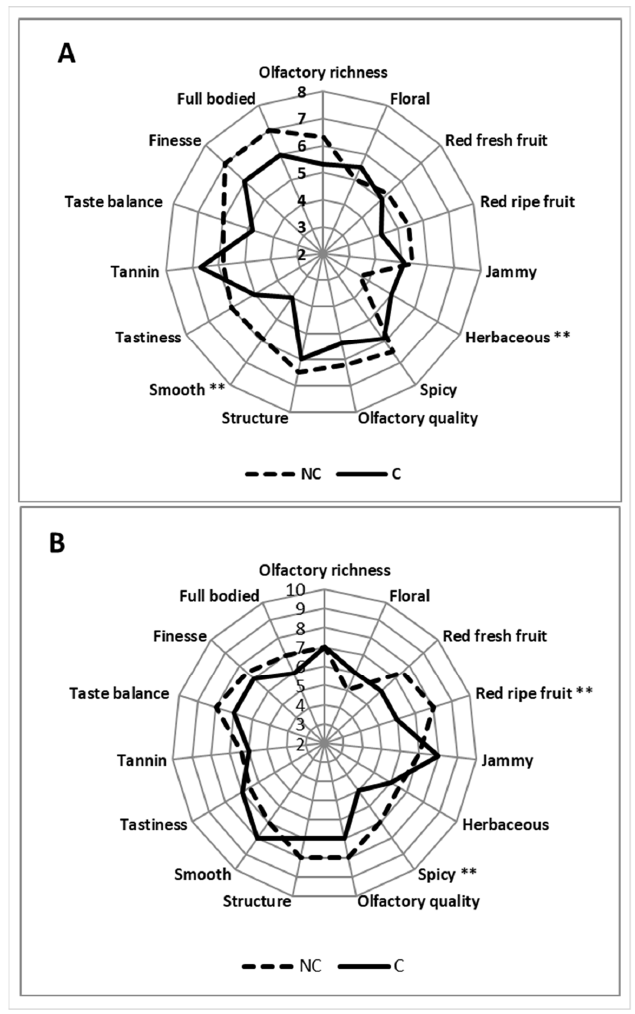
Figure 10. Results of tasting for wines in 2016 ( A ) and 2017 ( B ) years. ** indicate a significant difference p ≤ 0.01 between C and NC